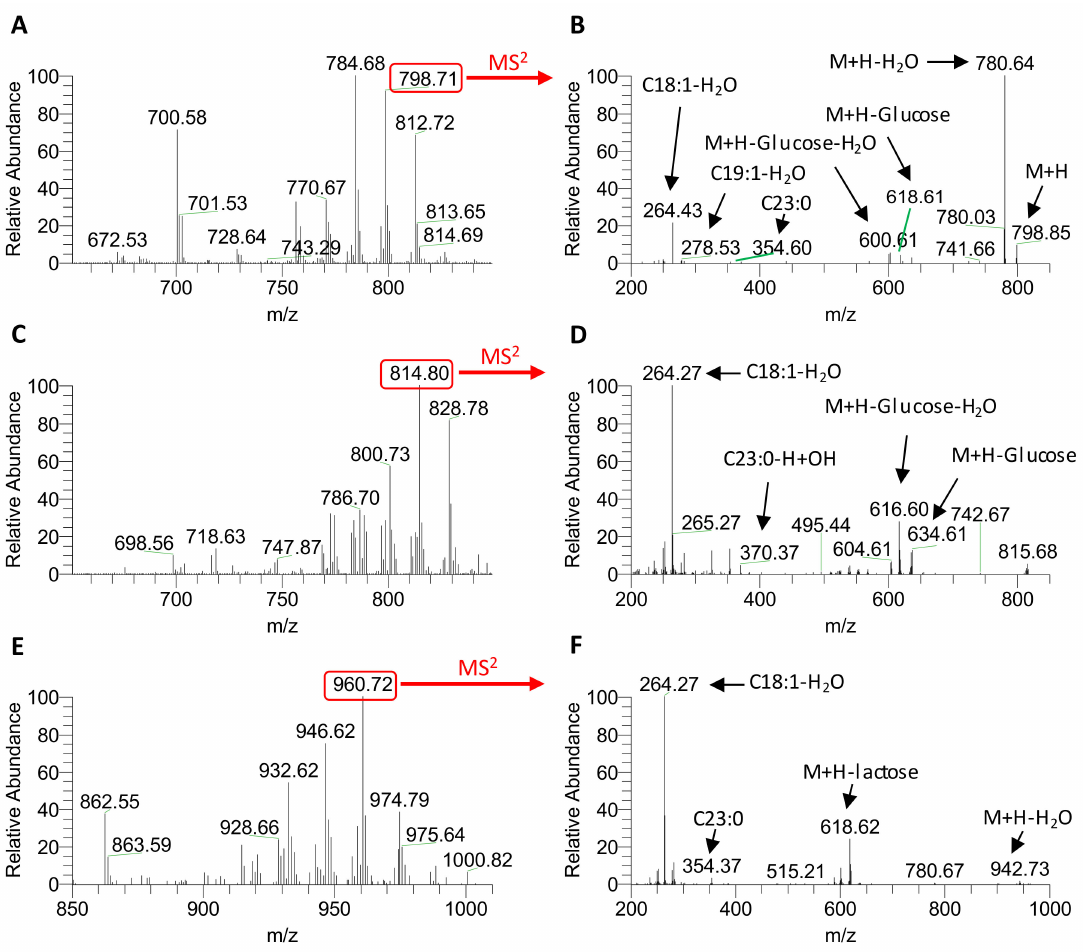
Figure 4. Mass spectra (positive mode) of Crb peak 1 ( A ), Crb peak 2 ( C ) and LacCer ( E ) from bovine milk and the MS 2 spectra of the 798.73 amu ion from Crb peak 1 ( B ), the 814.56 amu ion from Crb peak 2 ( D ) and the 960.73 amu ion from LacCer ( F